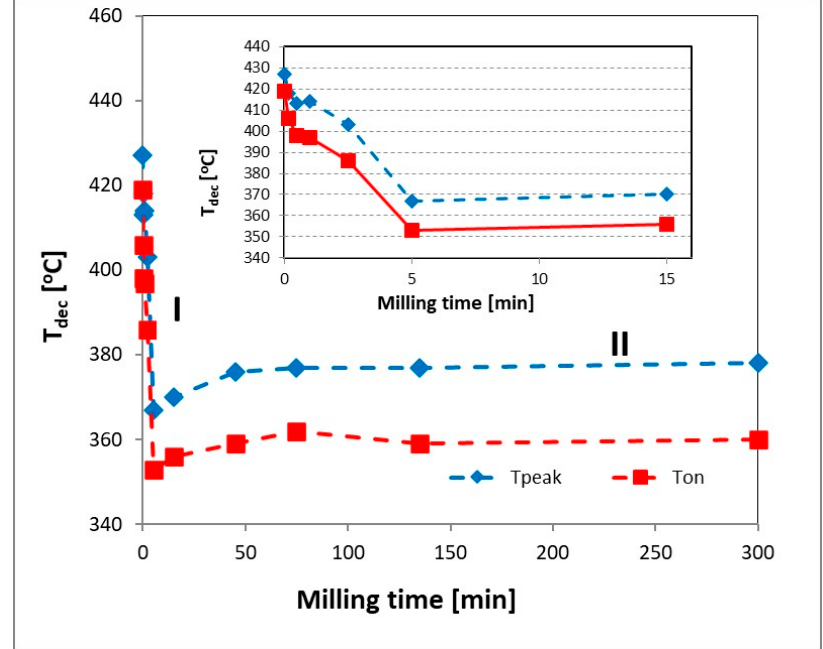
Figure 5. The changes in decomposition temperature for as-received and milled MgH 2 .